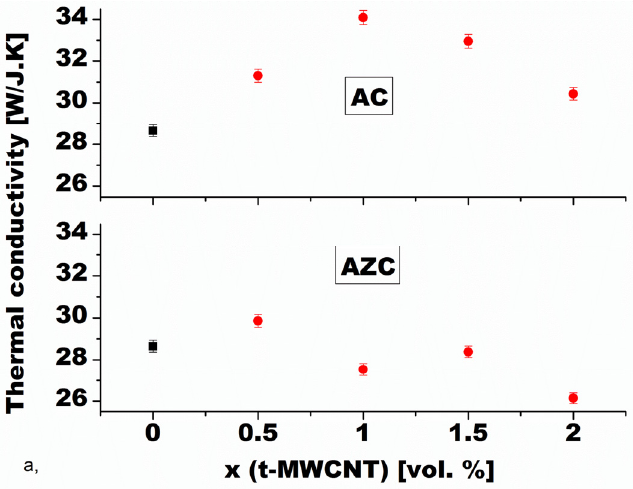
Figure 8. Composition dependence of thermal conductivity of Al 2 O 3 -MWCNT